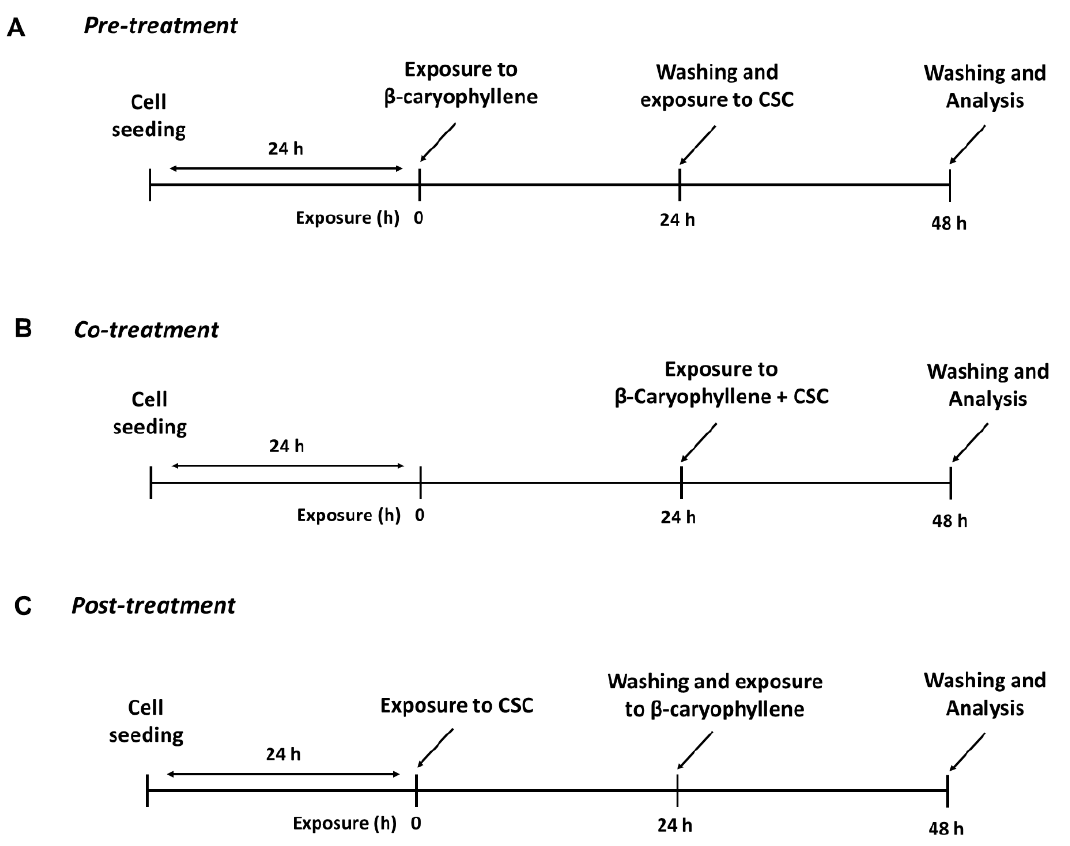
Figure 2. Scheduled treatment protocols applied to evaluate the chemopreventive properties of β -caryophyllene towards cigarette smoke condensate (CSC) in triple-negative breast cancer MDA- MB-468 cells: pre-treatment ( A ), co-treatment ( B ) and post-treatment ( C ).